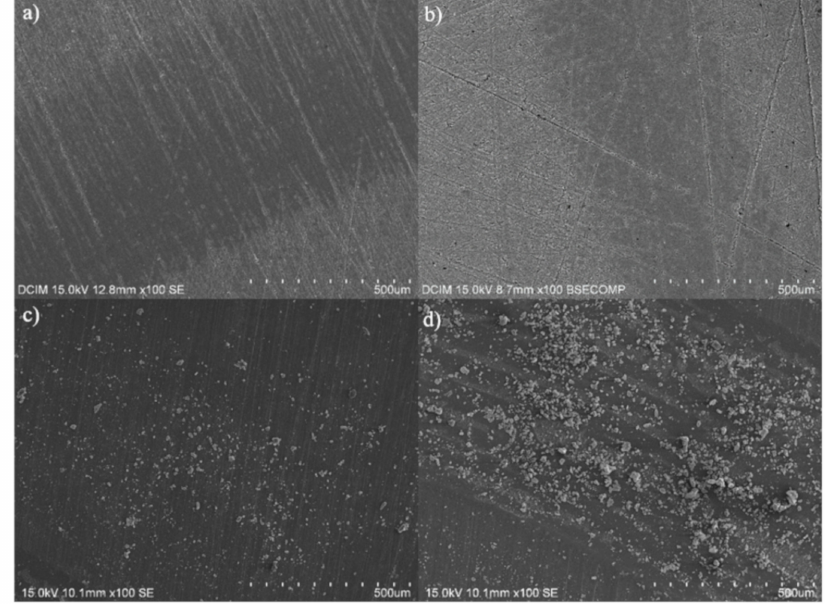
Figure 7. SEM images of worn surfaces of nanocomposites with 5 wt.% ( a ) and 8 wt.% ( b ) of non-functionalised GNPs and 5 wt.% ( c ) and 8 wt.% ( d ) of amino-functionalised